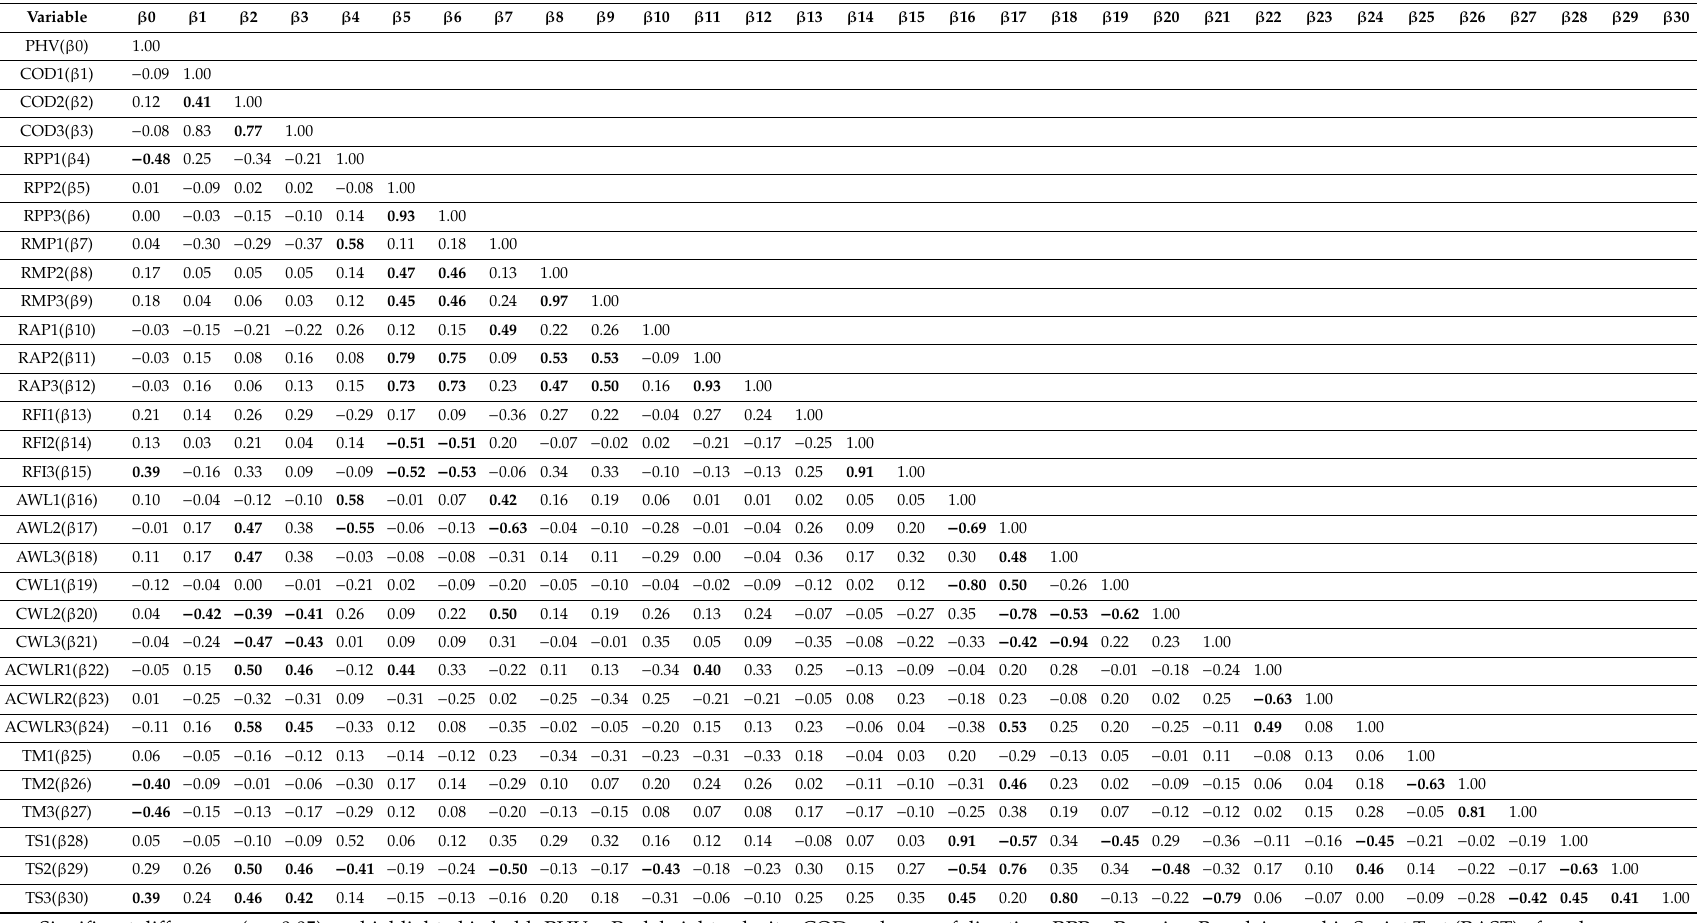
Table 2. Correlation analysis between the workload parameters and physical fitness tests with peak height